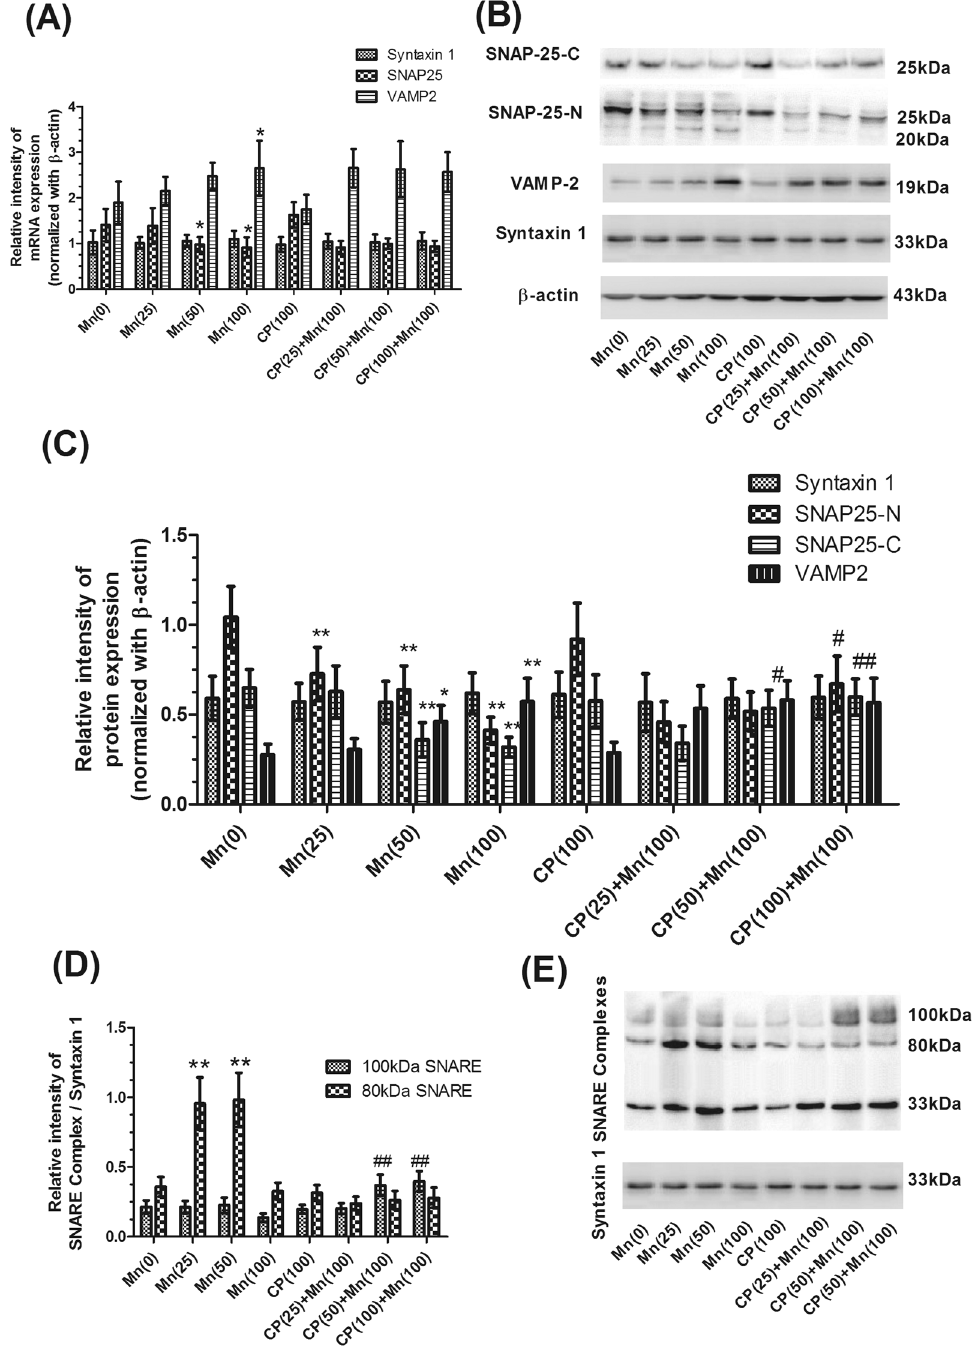
Figure 5. Calpeptin abated Mn disturbed the expression of SNARE complex associated proteins and the down- regulation of SNARE complex formation. ( A ) The mRNA expression levels were analyzed using a real-time RT-PCR assay to measure the expression of Syntaxin 1, SNAP-25 and VAMP-2 gene. Expression of Syntaxin 1, SNAP-25 and VAMP-2 gene were normalized with β -actin gene. For relative quantification of the tested, we used the comparative CT method ( △△ CT). ( B ) The western blotting products of Syntaxin 1, N-terminal of SNAP- 25, C-terminal of SNAP-25, VAMP-2 and β -actin. ( C ) Semi-quantitative analysis of the protein expressions of Syntaxin 1, N-terminal of SNAP-25, C-terminal of SNAP-25 and VAMP-2 were shown. Expression of Syntaxin 1, SNAP-25 and VAMP-2 protein were normalized with β -actin protein. ( D ) Semi-quantitative analysis of the protein expressions of SNARE complex protein was shown. Expression of SNARE complex protein was normalized with Syntaxin 1 protein. ( F ) The western blotting products of SNARE complex protein. Data are expressed as a percentage of controls, the values are expressed as means ± S.D., n = 6. * P < 0.05, ** P < 0.01 significantly different form control group, # P < 0.05, ## P < 0.01 significantly different form 100 μ mol/kg MnCl 2 - treated